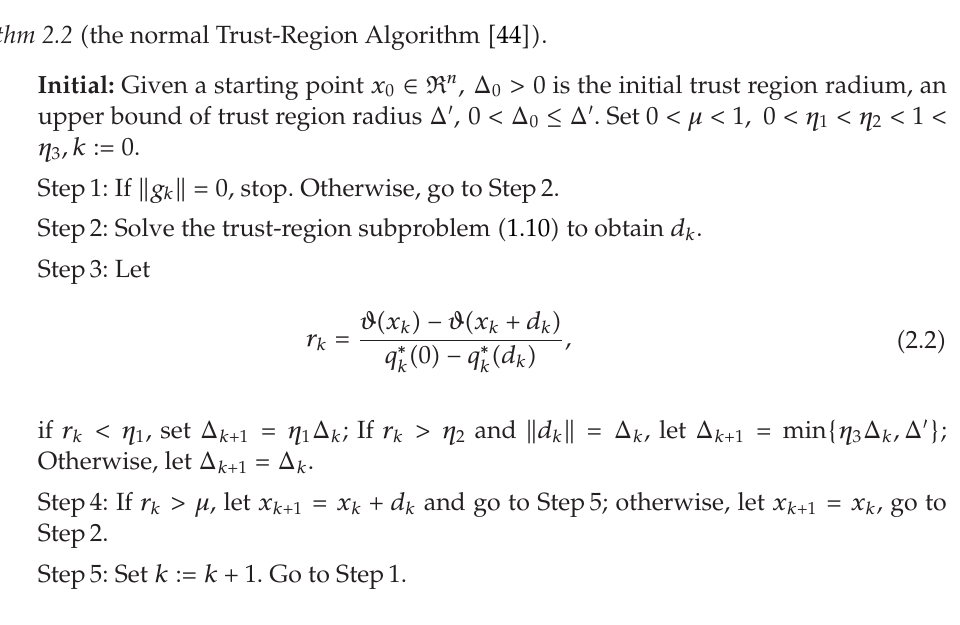
Algorithm 2.2 (cid:2) the normal Trust-Region Algorithm (cid:7) 44 (cid:8)(cid:3)